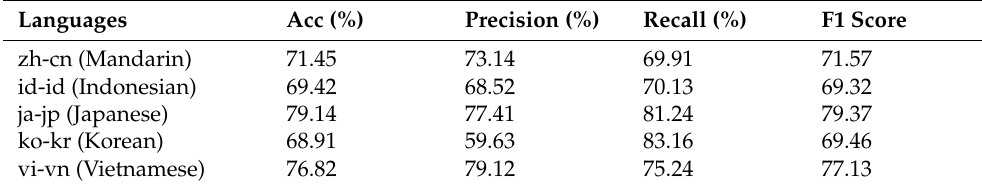
Table 5. Experimental results of improved models on multilingual cocktail party data.